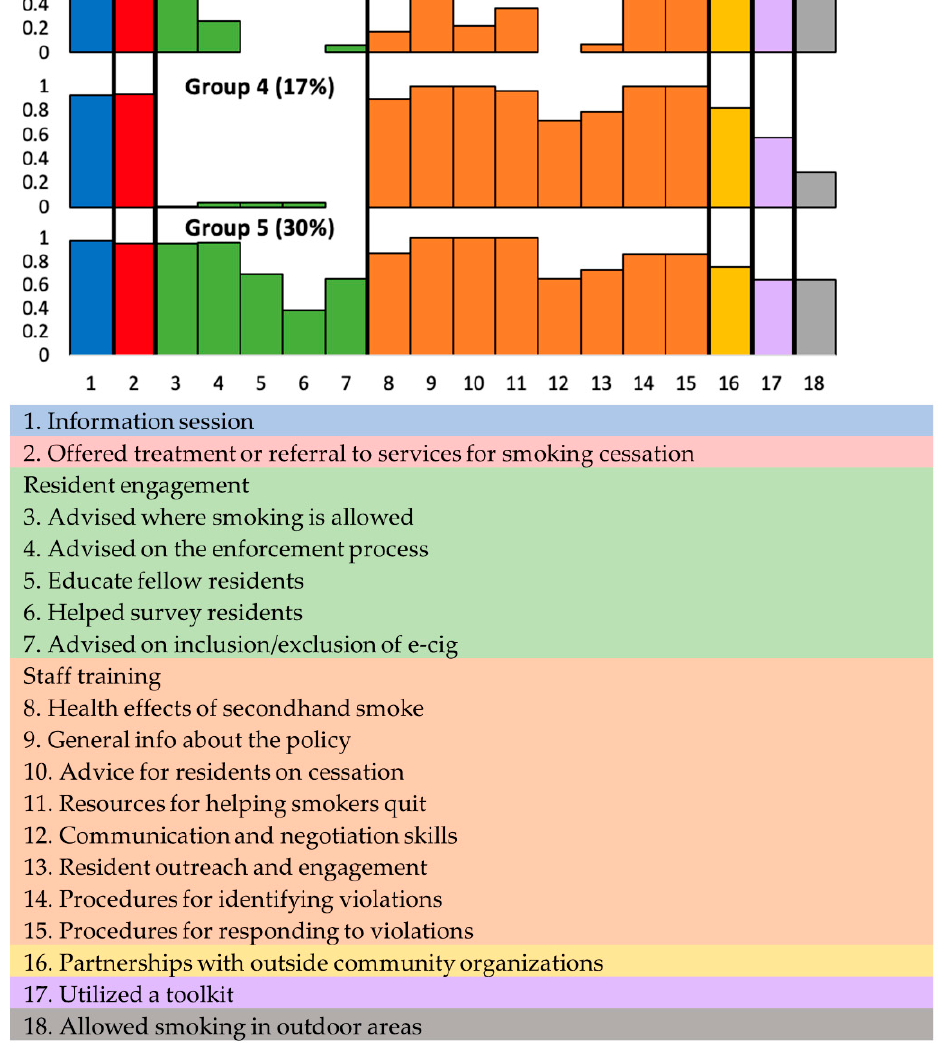
Figure 1. Marginal probabilities of practicing implementation strategies by the five latent classes of public housing from latent class analysis ( n = 161).